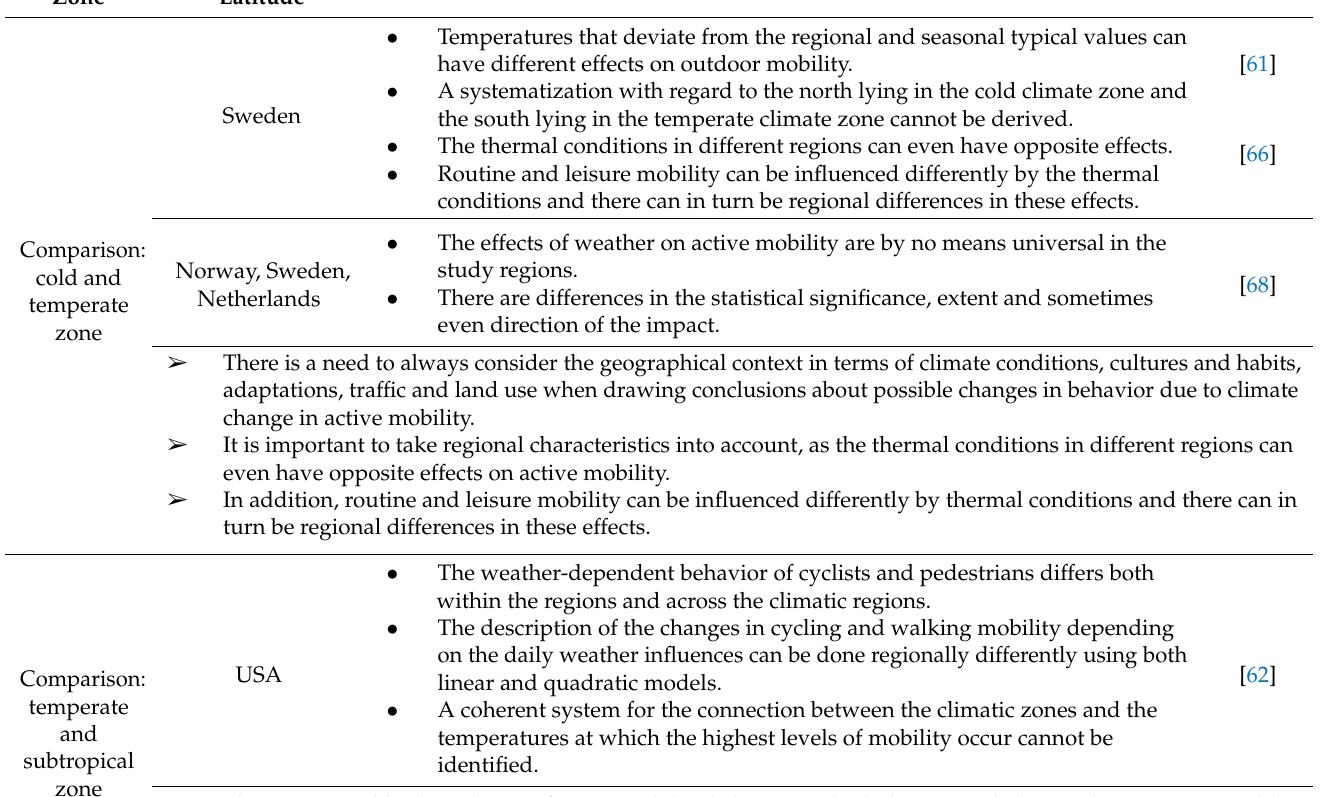
Key Messages (Bullet Points) and Conclusions (Bullet